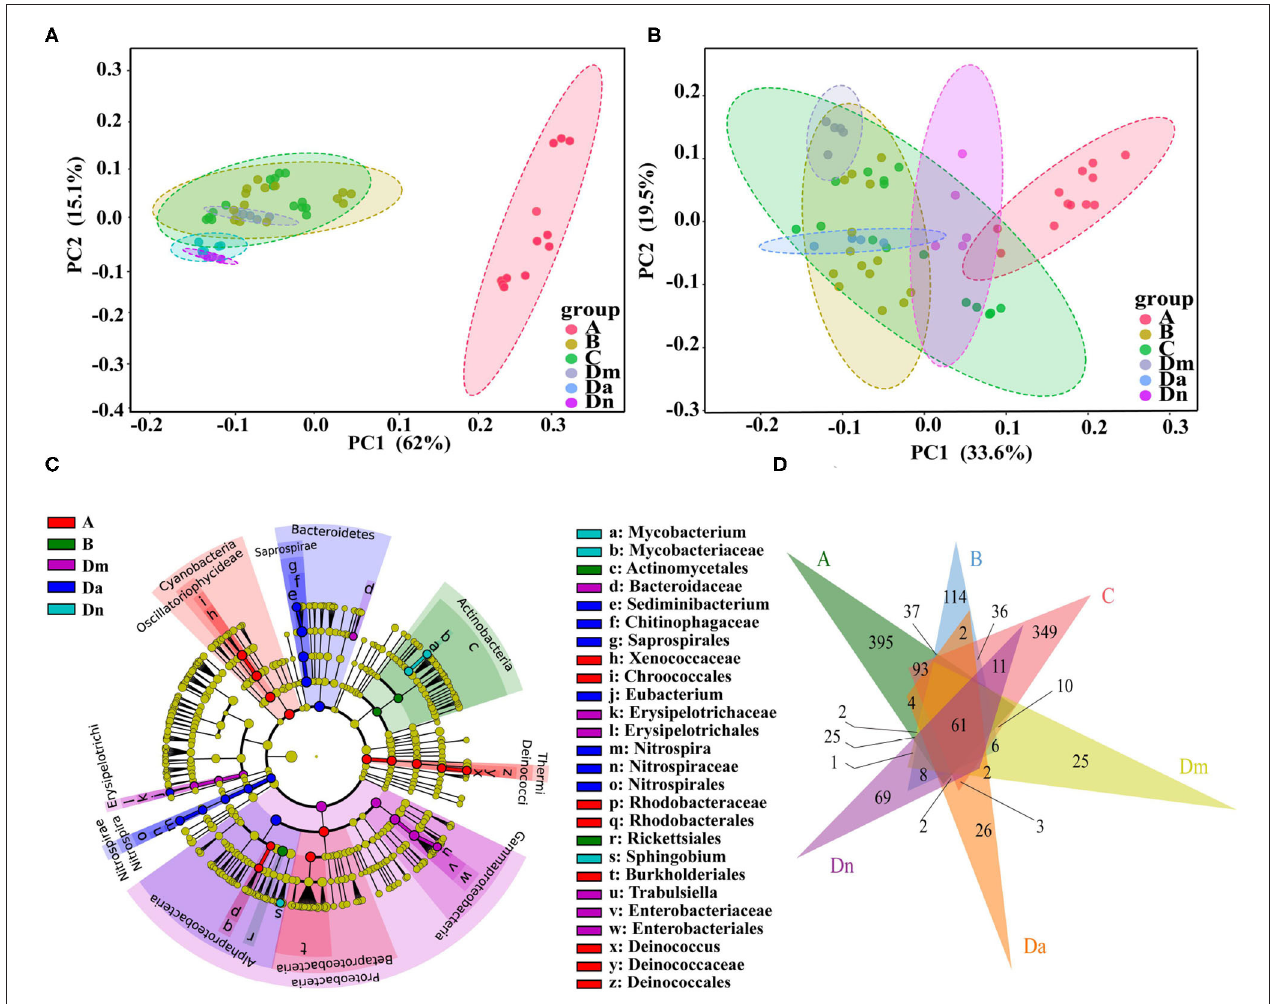
FIGURE 3 | Beta diversity and taxonomic features of bacterial populations from six airborne samples. Principal coordinate analysis plots of (A) weighted and (B) unweighted UniFrac distances with samples colored by sampling site. The percentage of diversity captured by each coordinate is shown. (C) Cladogram for the taxonomic representation of significant differences among different sampling groups. The colored nodes from the inner to the outer circles represent taxa from the phylum to genus level. Significantly different taxa (linear discriminant analysis > 3) are indicated by different colors representing the four groups ( P < 0.05). (D) Venn diagram based on OTUs. Different colors represent different sampling sites. The overlaps represent the common taxa between sampling sites, and the non-overlapping portions represent unique taxa in each sampling